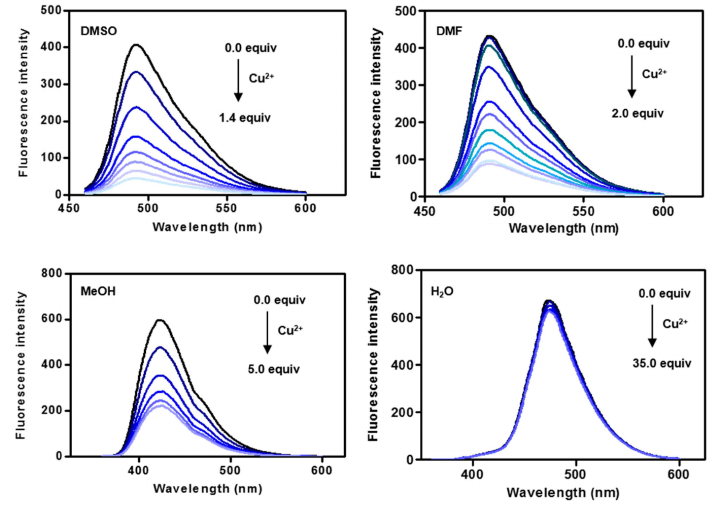
Figure 3. Changes in emission spectra upon addition of Cu 2+ . CP3 (1 µ M) was titrated against increasing amounts of Cu 2+ (0 to 35 µ M) in various solvents with excitation at 441 nm for DMSO and DMF, 347 nm for MeOH and 344 nm for H 2 O, respectively.